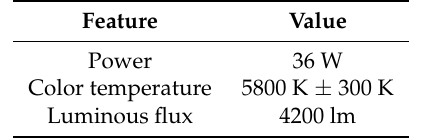
Table A1. Main features of the light source employed in 3DWF